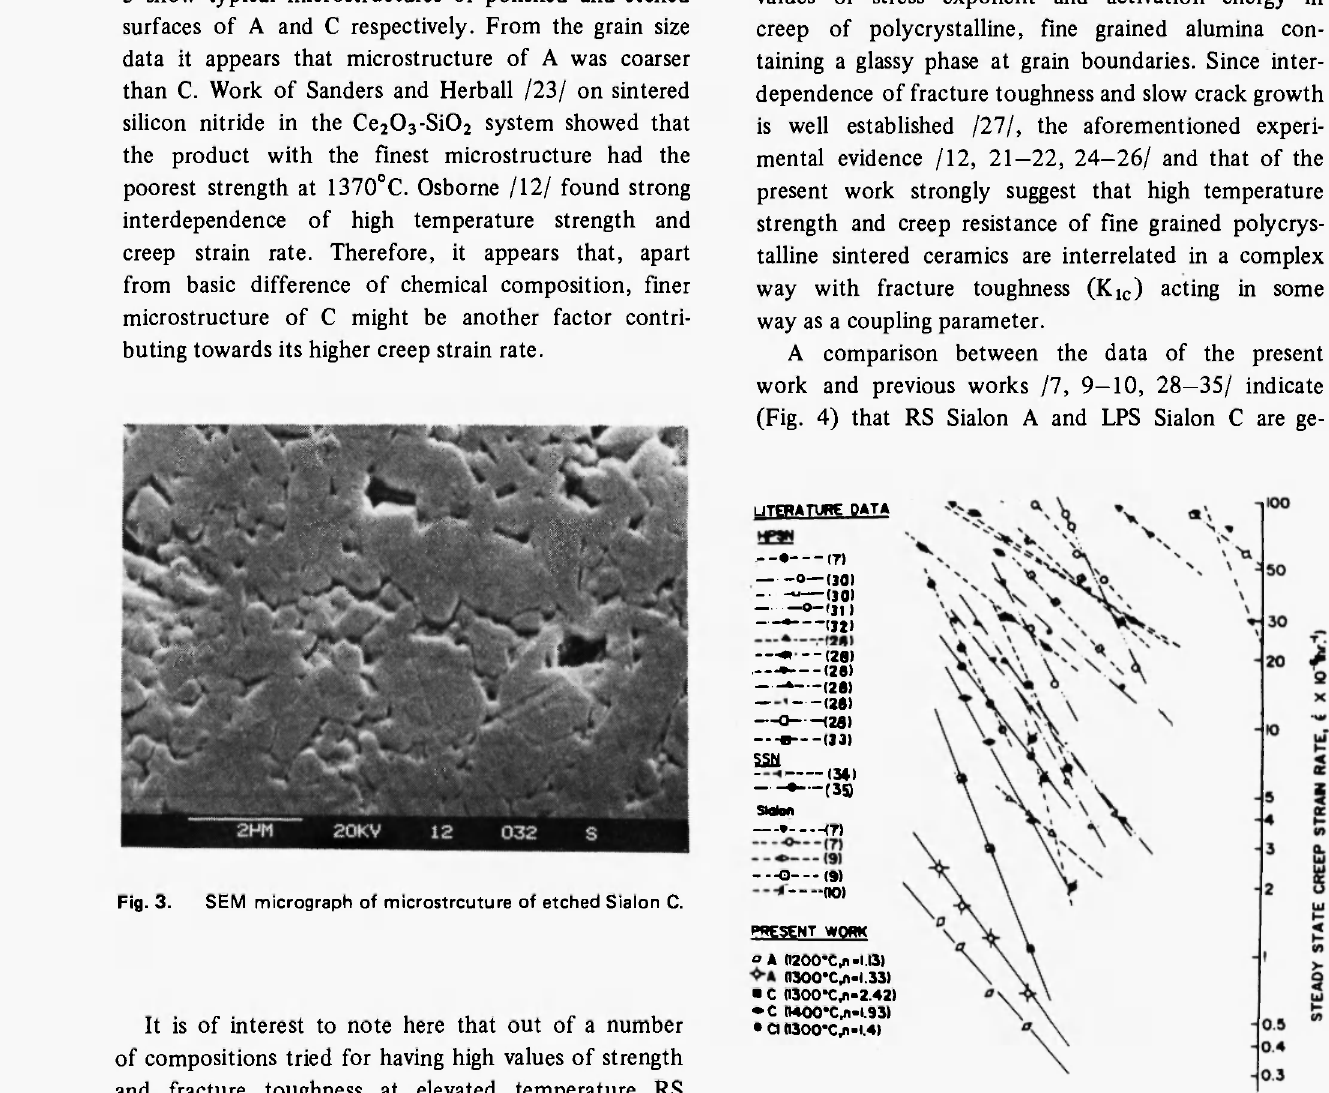
Fig. 3. SEM micrograph of microstrcuture of etched Sialon C.